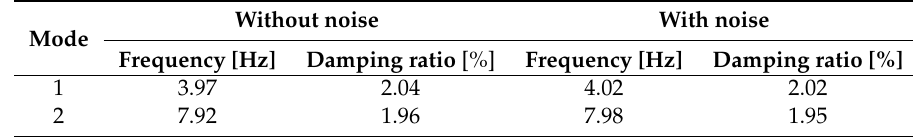
Table 3. The effect of noise on the identified parameters.